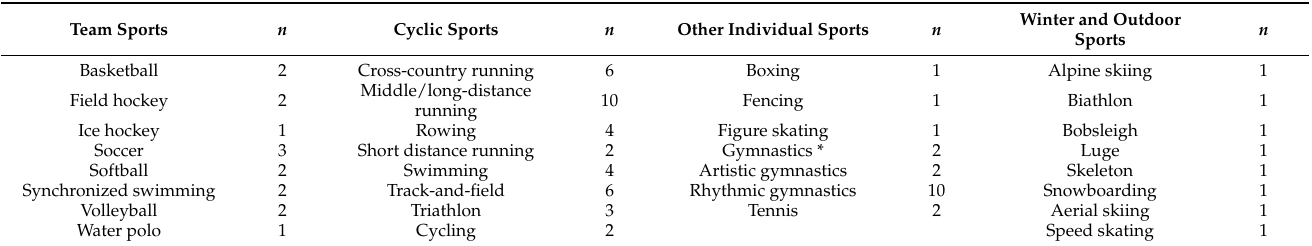
Table 1. Sports disciplines and the number of studies assessing the prevalence of menstrual cycle